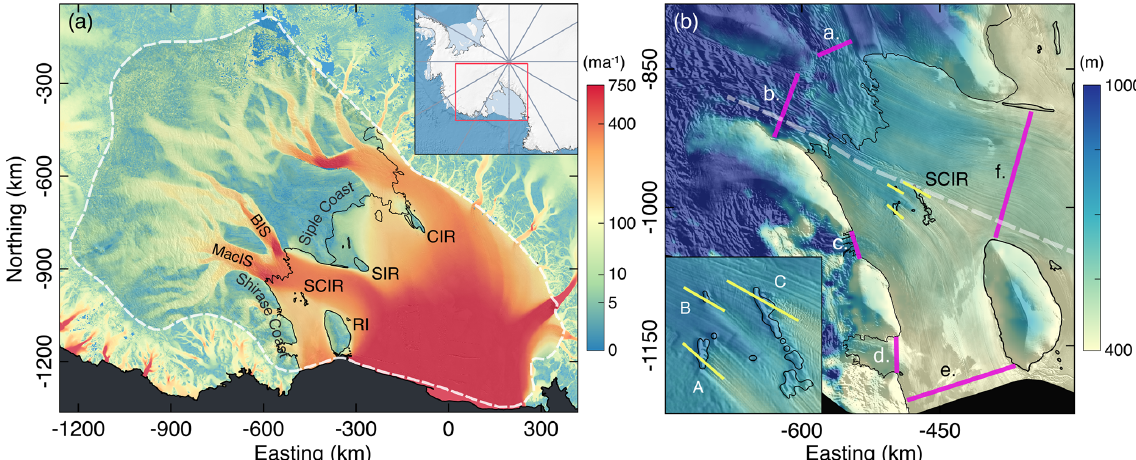
Figure 1. Pinning points in the RIS. In panel (a) , large pinning points are labelled as follows: SCIR – the Shirase Coast Ice Rumples, RI – Roosevelt Island, SIR – Steershead Ice Rise, and CIR– Crary Ice Rise. The colour map of surface ice velocity magnitude is from the MEaSUREs velocity dataset (Rignot et al., 2011a). The black line indicates the grounding lines (Bindschadler et al., 2011), and the white dashed line is the limit of the finite element model domain. Panel (b) shows the along-flow cross sections intersecting the SCIR in Figs. 3 and 10 (yellow and white dashed lines), as well as the gates used for mass flux calculations in Table 3. The colour map of ice thickness is from the Bedmap2 compilation (Fretwell et al., 2013). In each figure from hereon, datasets are mapped with a polar stereographic projection with a central meridian of 0 ◦ and a standard latitude of 71 ◦ S and, in most cases, overlayed onto the MODIS MOA (Haran et al.,